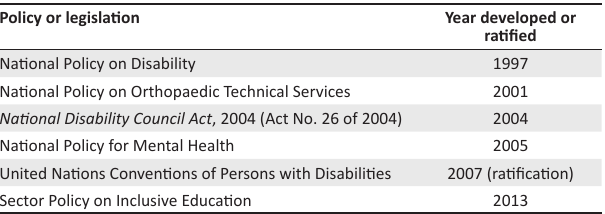
TABLE 1: Progression of formulation and ratification of policies and legislative